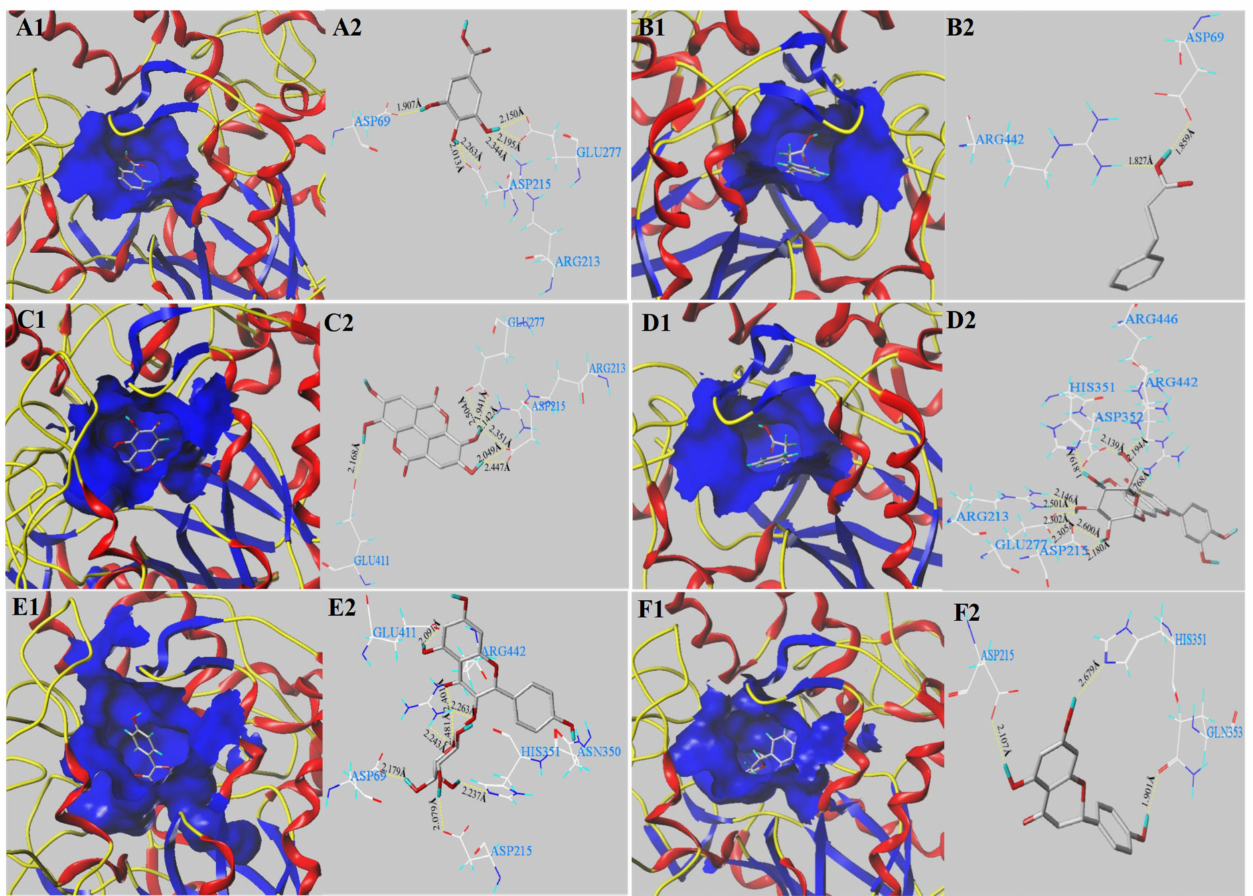
Figure 3. The 3D conformations of the major phenolics docked with α -glucosidase: gallic acid ( A1 , A2 ); p-hydroxycinnamic acid ( B1 , B2 ); ellagic acid ( C1 , C2 ); luteolin-7-O-glucoside ( D1 , D2 ); astragalin ( E1 , E2 ); naringenin ( F1 , F2 ) with the active pocket of α -glucosidase. The dashed yellow line presents hydrogen bonds